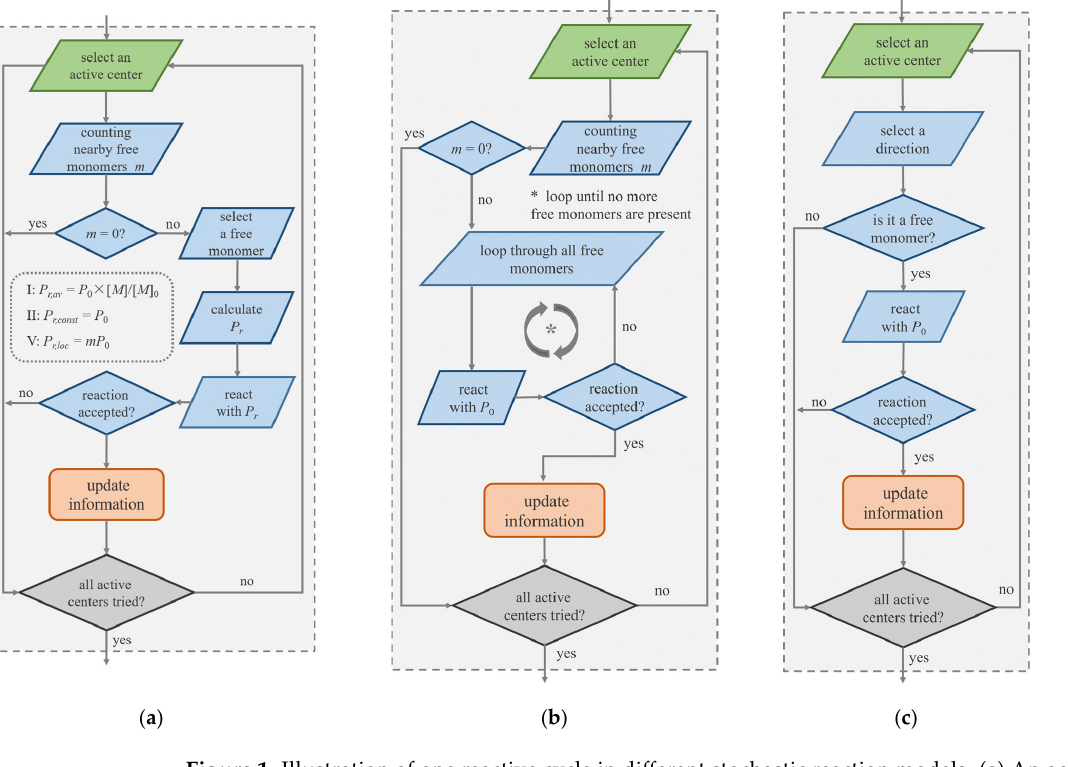
Figure 1. Illustration of one reactive cycle in different stochastic reaction models. ( a ) An active center reacts with a free monomer in the reaction radius with probability P r . The methods to calculate P r in Versions I, II, and V are shown. ( b ) In Version III, an active center sequentially reacts with nearby free monomers. ( c ) In Version IV, one neighboring direction of an active center is selected in a lattice simulation; if it is occupied by a monomer, a reaction is tried.